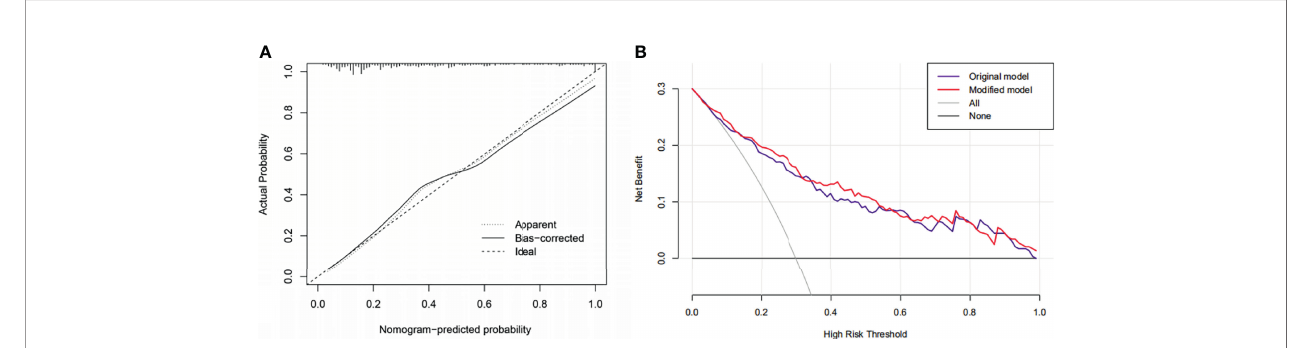
FIGURE 8 | (A) Calibration curves of the nomogram. (B) Decision curve analysis (DCA) of the original and the modi fi ed model.